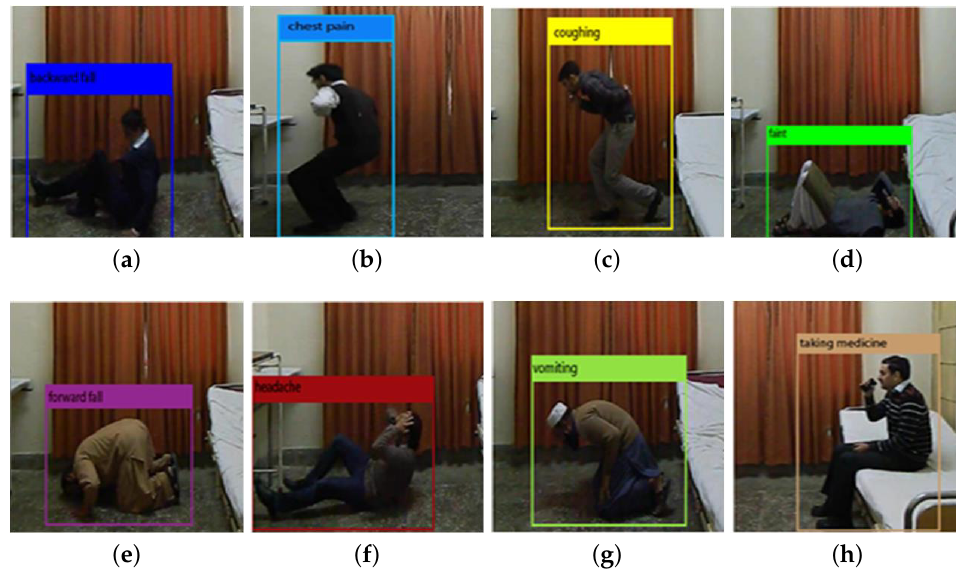
Figure 6. Different abnormal activities recognized: ( a ) backward fall; ( b ) chest pain; ( c ) coughing; ( d ) faint; ( e ) forward fall; ( f ) headache; ( g ) vomit; and ( h ) taking